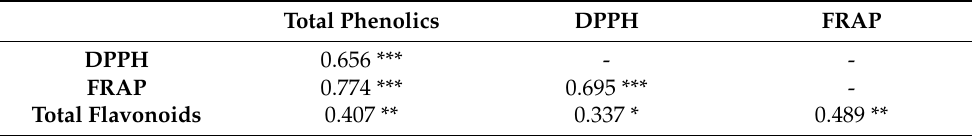
Table 4. Correlation matrix for fruit bioactive compounds of of Pyrus elaeagrifolia Pall. subsp. elaeagrifolia